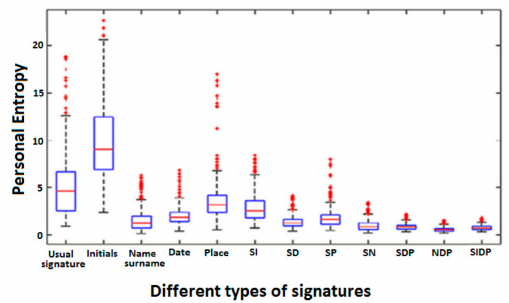
Figure 10. Boxplots of PE values for the 74 persons per signature